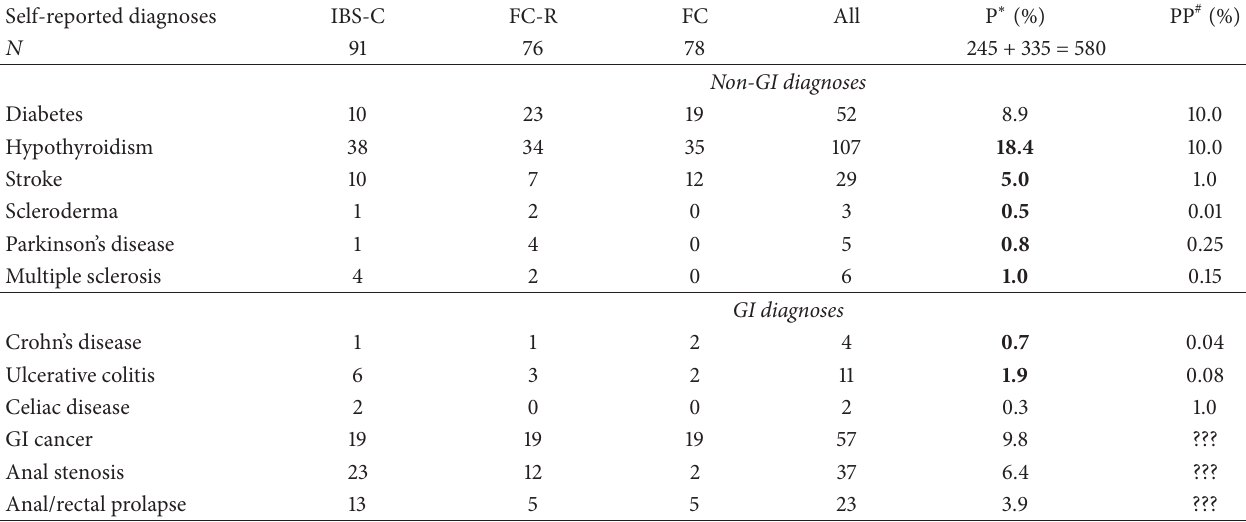
Table 1: Somatic diagnoses reported by constipated individuals identified as meeting IBS-C, FC-R, and FC definitions (number of cases, more than one allowed). Bold indicates increased prevalence as compared to population data.